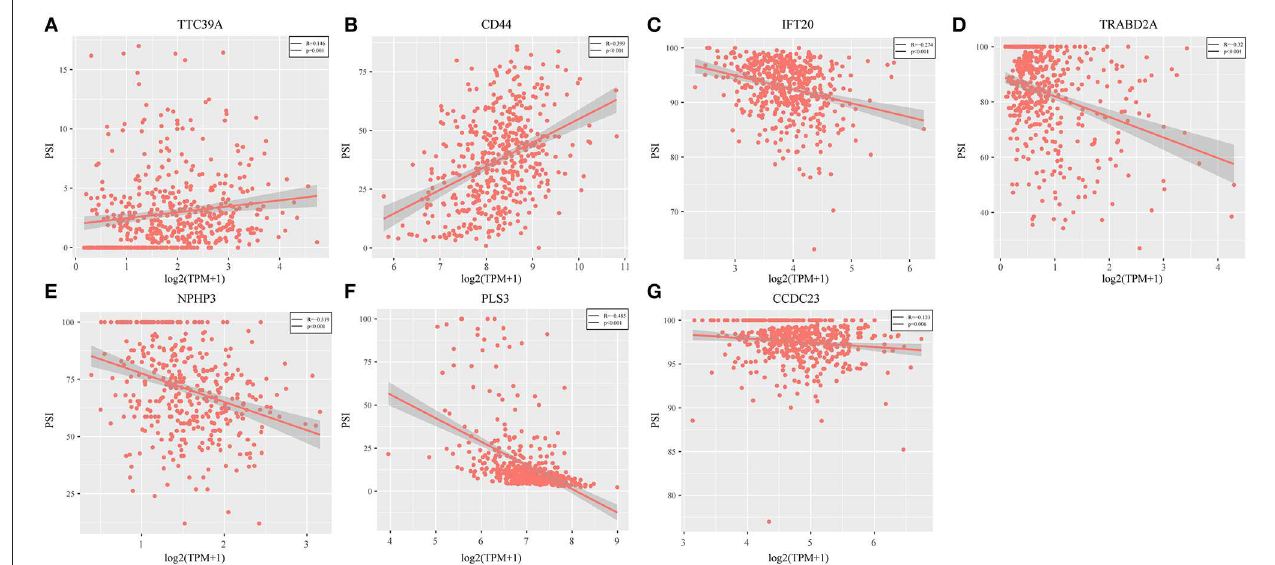
FIGURE 5 | Seven intersected genes related to survival and recurrence were selected. It could be observed TTC39A (A) and CD44 (B) were positively correlated. But IFT20 (C) , TRABD2A (D) , NPHP3 (E) , PLS3 (F) , and CCDC23 (G) were negatively correlated ( P < 0.05).